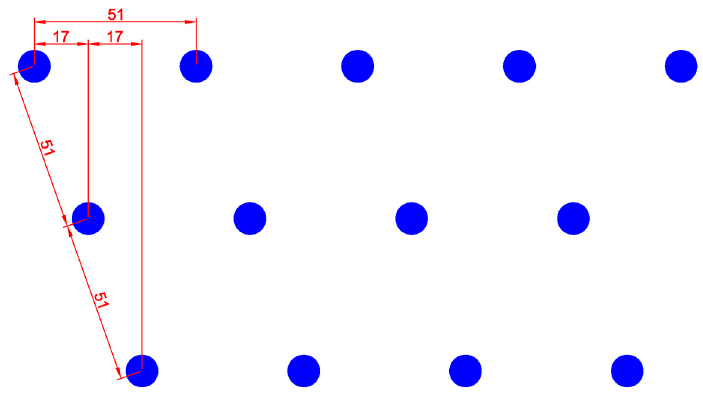
Figure 11. Wave farm layout. Table 3. Main data of wave farm.